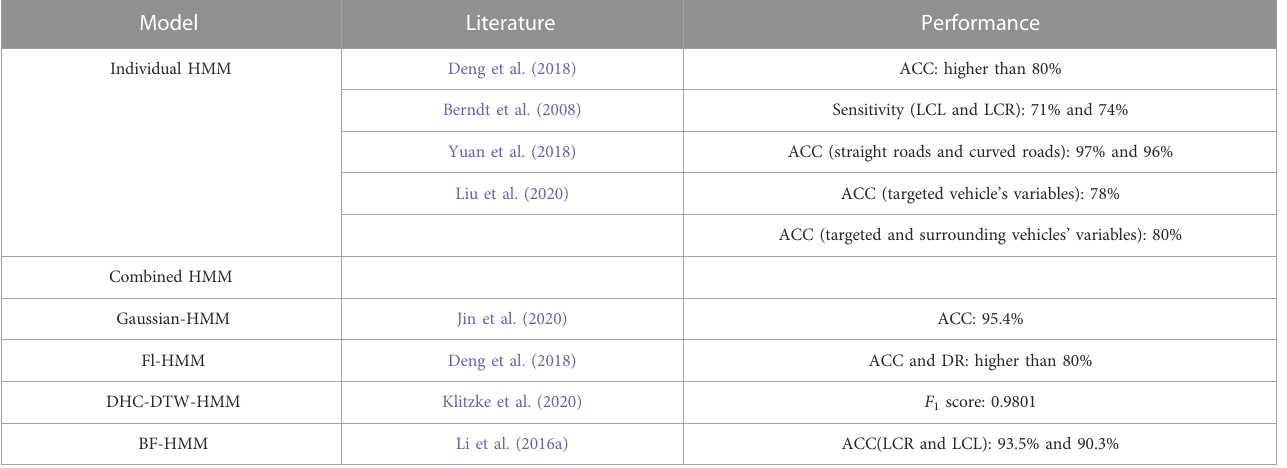
TABLE 5 Summary of HMM-based models for lane-changing